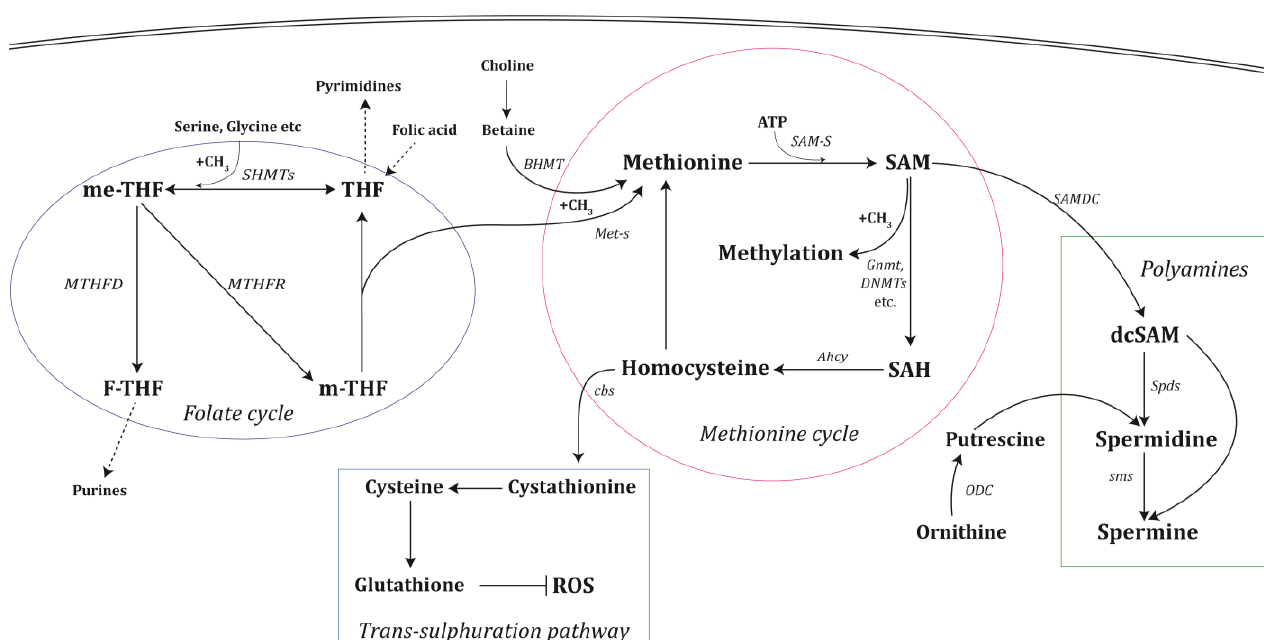
Figure 1. One-carbon metabolism includes the methionine cycle, which is linked to the folate cycle, polyamine synthesis, and the trans-sulphuration pathway. Enzymes catalyzing significant reactions are shown in italics. Metabolite abbreviations are: SAM: S-adenosyl methionine; SAH: s-adenosyl homocysteine; dcSAM: decarboxy-s-adenosyl methionine; ROS: reactive oxygen species; THF: tetrahydrofolate; m-THF: methyl-THF; me-THF: methylene-THF; F-THF: formyl-THF.